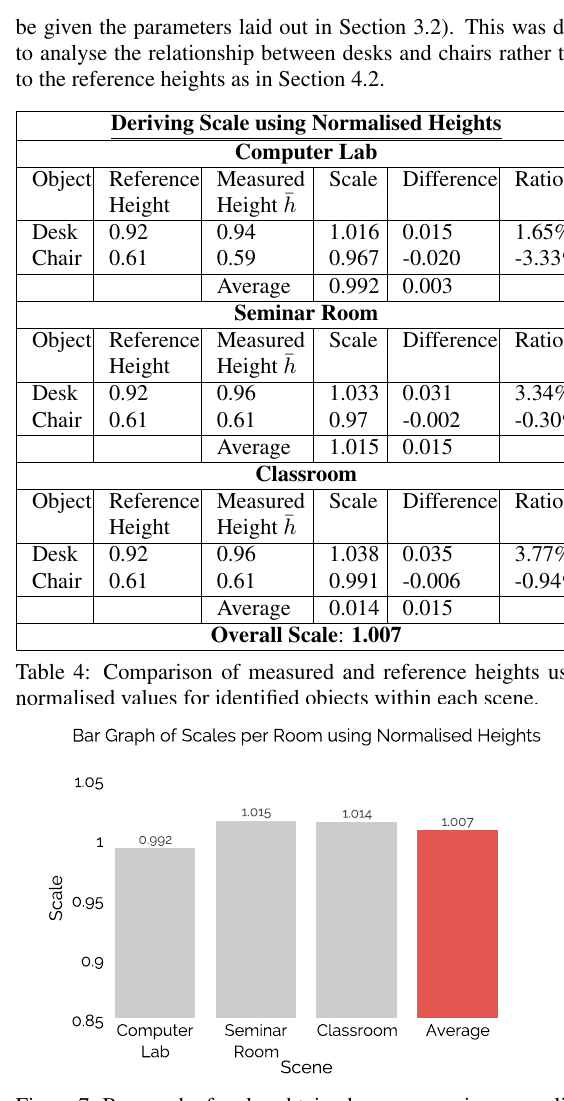
Figure 7: Bar graph of scales obtained per scene using normalised heights.